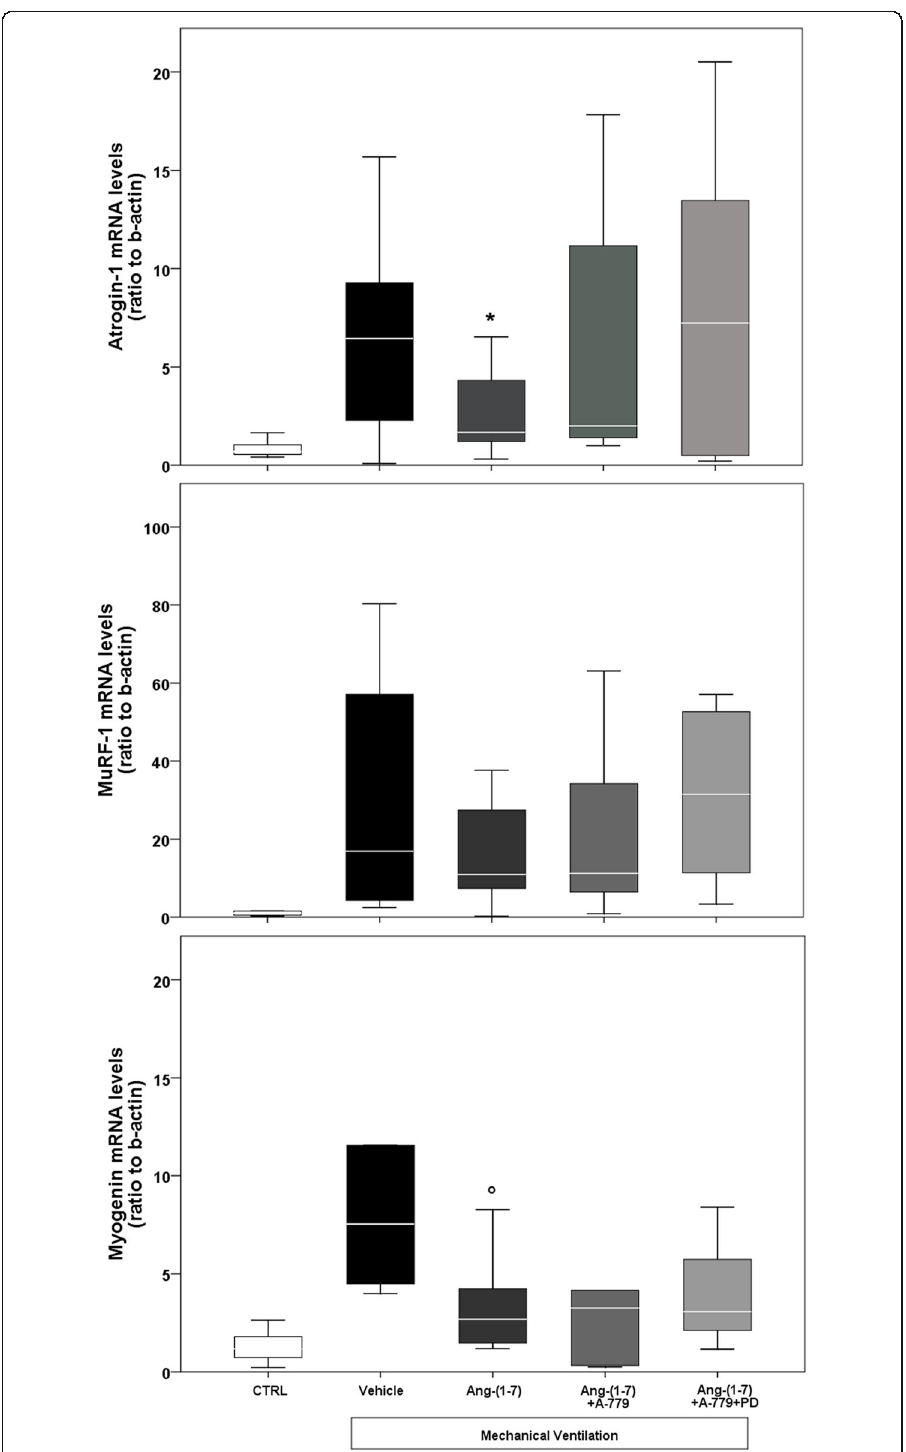
Fig. 3 Real-time PCR. CTRL ( n = 6): unventilated controls; vehicle ( n = 6): VIDD + saline treatment; Ang-(1 – 7) ( n = 6): VIDD + Ang-(1 – 7) treatment; Ang-(1 – 7) + A-779 ( n = 6): VIDD + Ang-(1 – 7) + A-779 treatment; Ang- (1 – 7) + A-779+PD ( n =6): VIDD + Ang-(1 – 7) + A-779 + PD123319 treatment; * p =0.035 vs vehicle; ° p